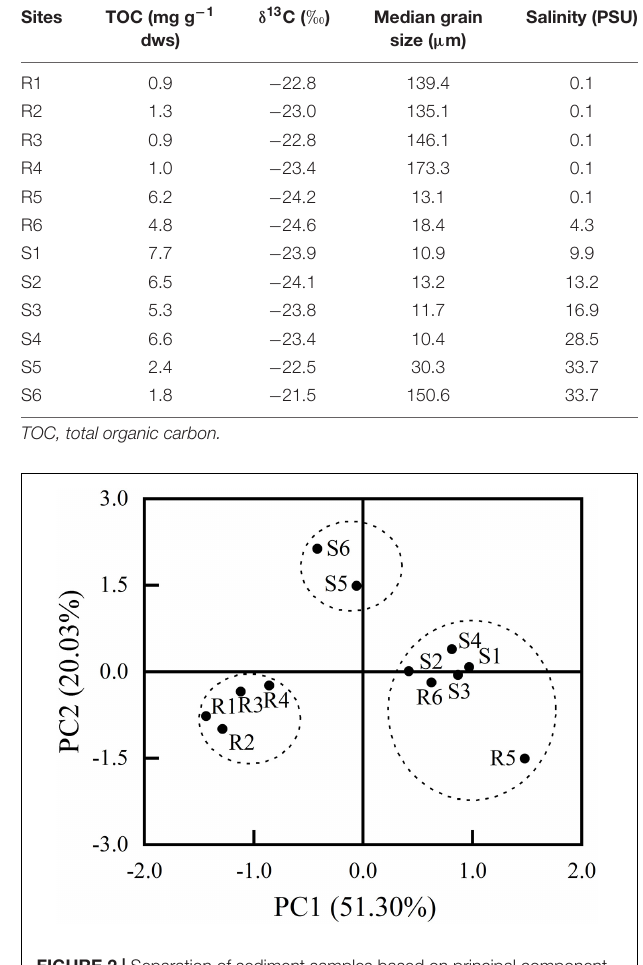
FIGURE 2 | Separation of sediment samples based on principal component analysis (PC1 and PC2) of bulk geochemical parameters [total organic carbon (TOC), δ 13 C, median grain size, and water